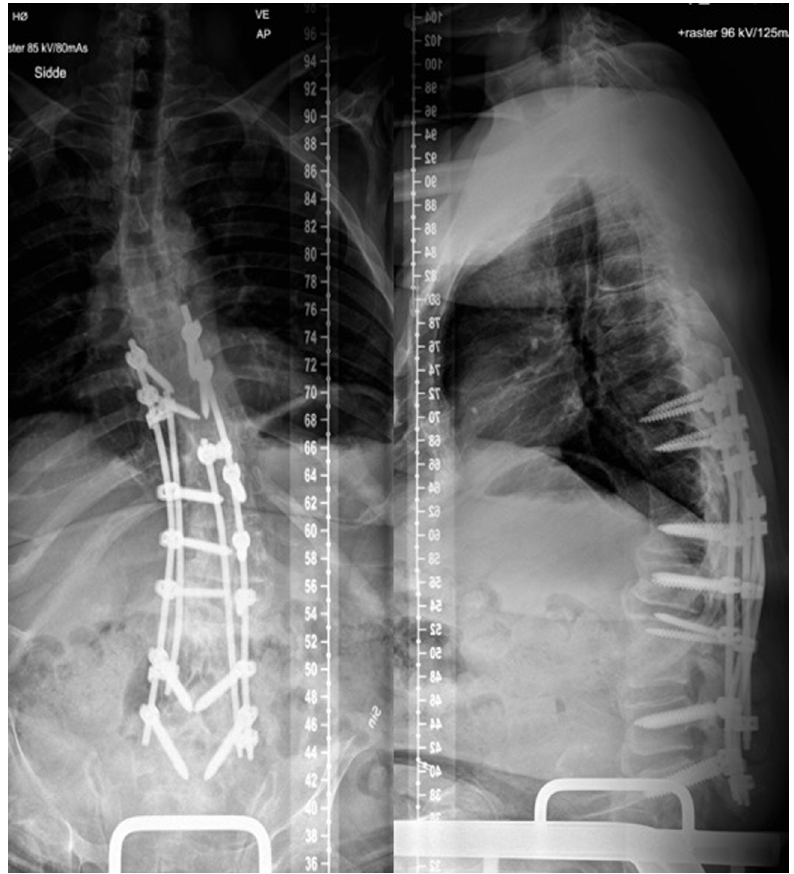
Figure 5. 1 year follow up radiograph shows good consolidation at the pseudoarthrosis site and correction of the